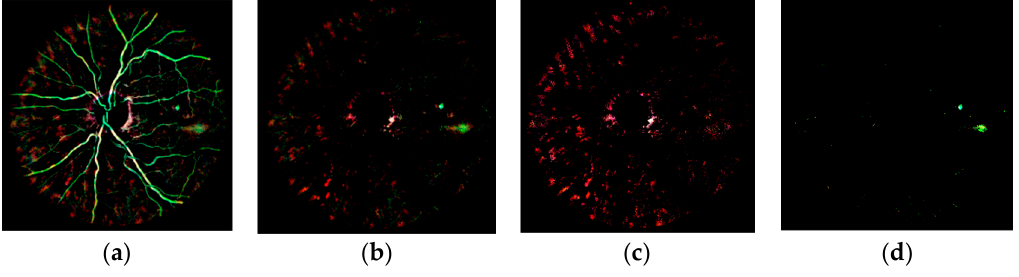
Figure 4. Red lesion candidate segmentation. ( a ) Image I dark . ( b ) Image I dark − 2 . ( c ) Image L chor − dark . ( d ) Image 𝐿 (cid:3045)(cid:3039)(cid:2879)(cid:3030)(cid:3028)(cid:3041)(cid:3031) . These images are shown with enhanced contrast for an easier readability. After preprocessing, inter- and intra-image variability was reduced. Hence, the color of the visible structures in 𝐼 (cid:3031)(cid:3028)(cid:3045)(cid:3038) was always consistent. This way, they could be directly separated using color and spatial information. The blood vessels, the choroidal atrophy, and the rest of dark pixels, which are RL candidates, are the structures of interest in 𝐼 (cid:3031)(cid:3028)(cid:3045)(cid:3038) that should be taken into account for RL detection.